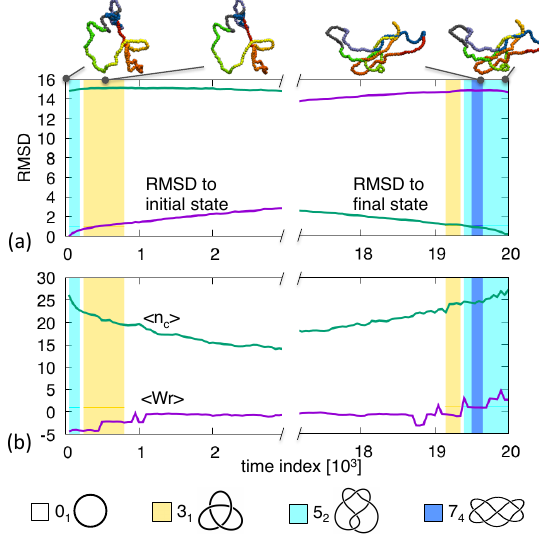
Figure 3. Transition pathway between two 5 2 knotted ring. The shown observables are the same as in Figure